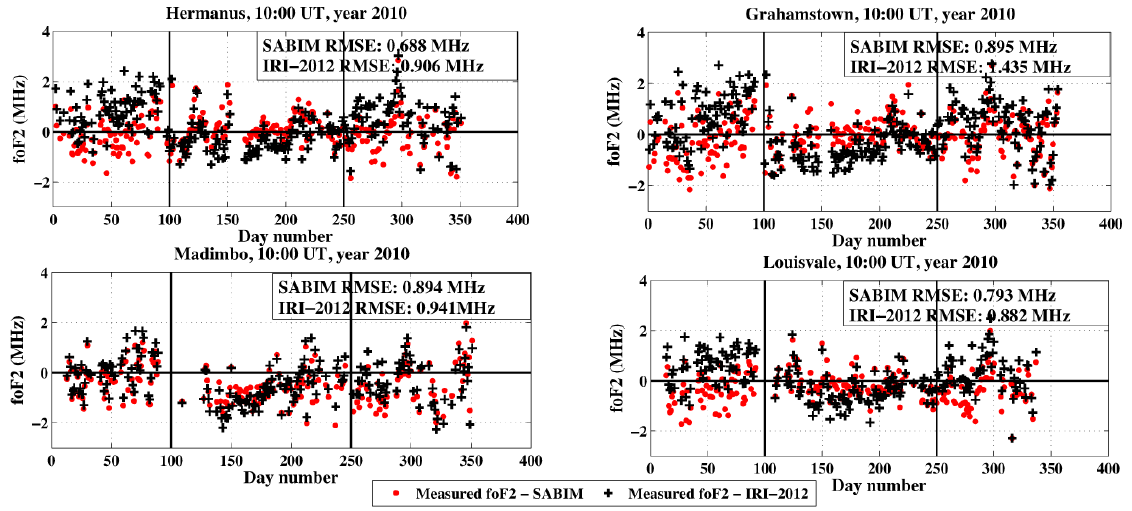
Figure 4. Annual variation of residues between the measured local noon (10:00 UT) foF2 values and the output from the models (SABIM and IRI-2012) for all 4 ionosonde stations.